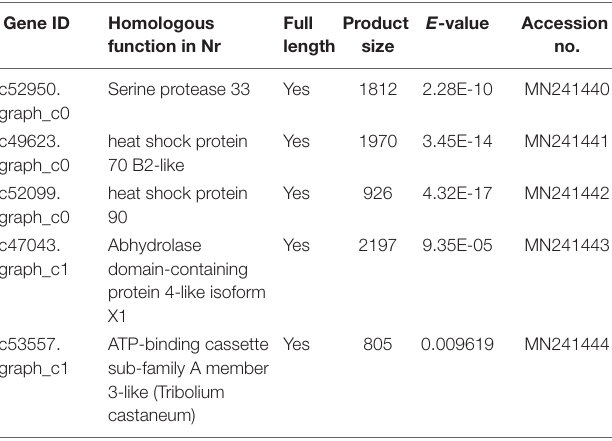
TABLE 6 | Development and enzyme-related differentially expressed genes were shown in